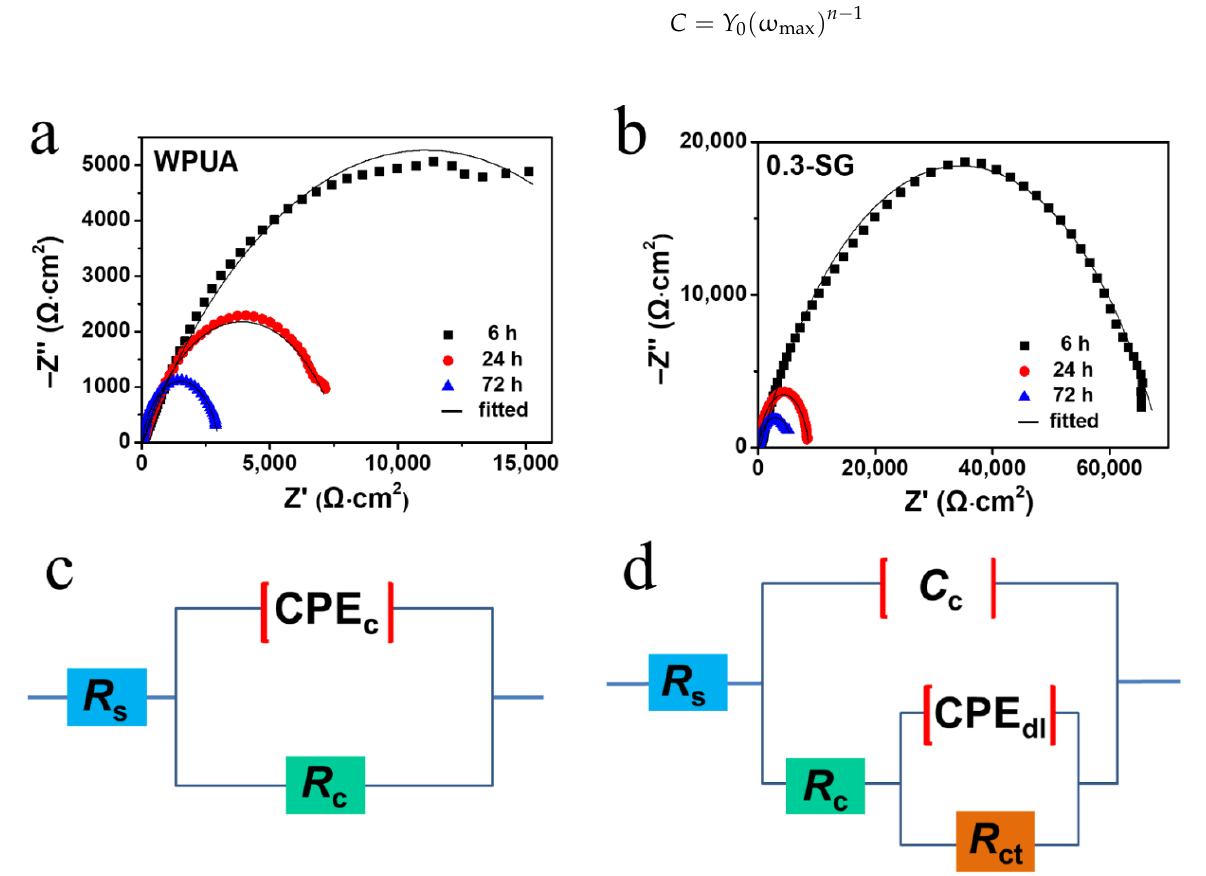
Table 3. The electrochemical parameter data of WPUA and 0.3-SG samples immersed for 6, 24, and 72 h. Time Sample